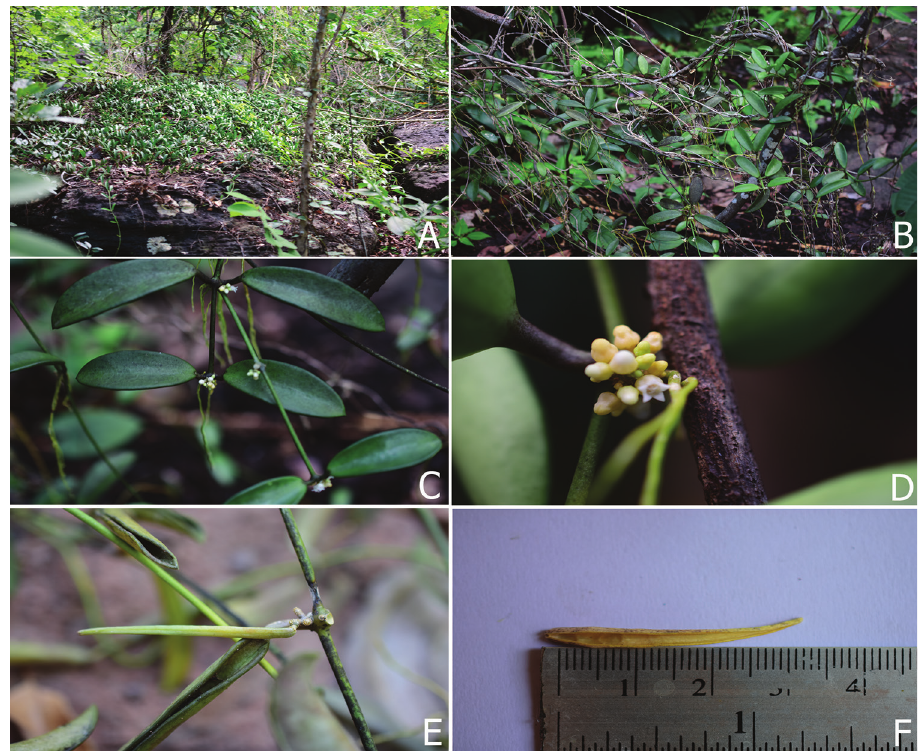
Figure 1. Dischidia phuphanensis . A Plant climbing on rock B plant climbing on branches of shrub 2–3 m tall C branches and leaves D inflorescence E follicle (nearly mature) F dehiscent follicle. Photo- graphed by Wannachai Chatan from W. Chatan 2489 ( A–D ) and W. Chatan 2904 ( E, F